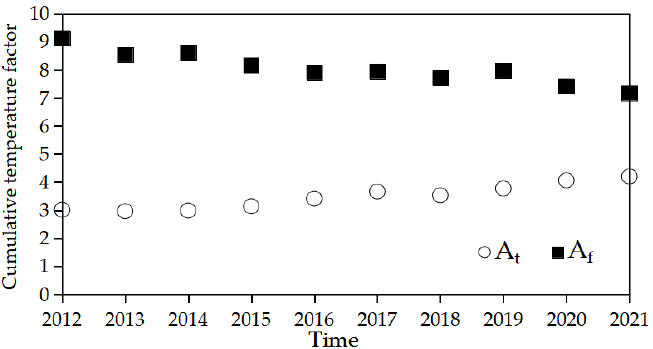
Figure 4. Cumulative temperature factors, A t and A f , in the period from 2012 to 2021.